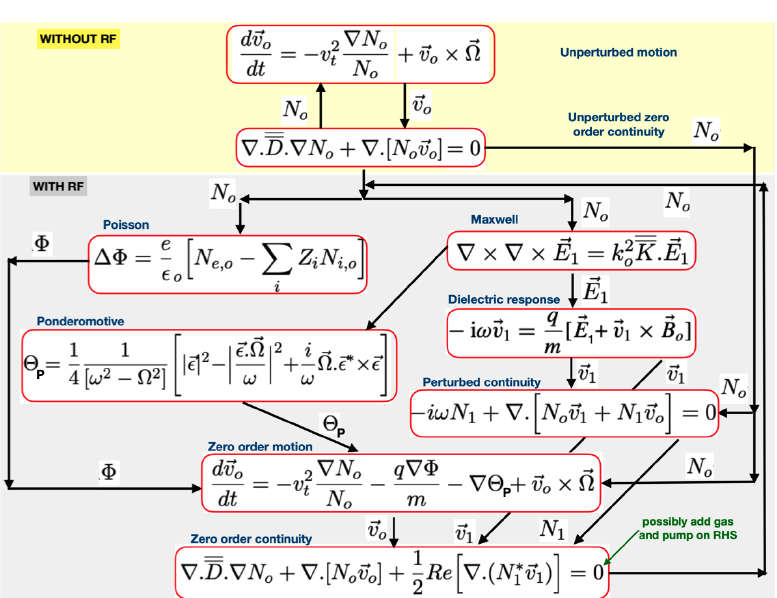
Figure 1. Scheme for modelling wave–plasma interaction. Note that at the outset when the radio frequency (RF) power, P RF = 0, charge neutrality is assumed, so that not only the ponderomotive but also the electrostatic potential is assumed to be